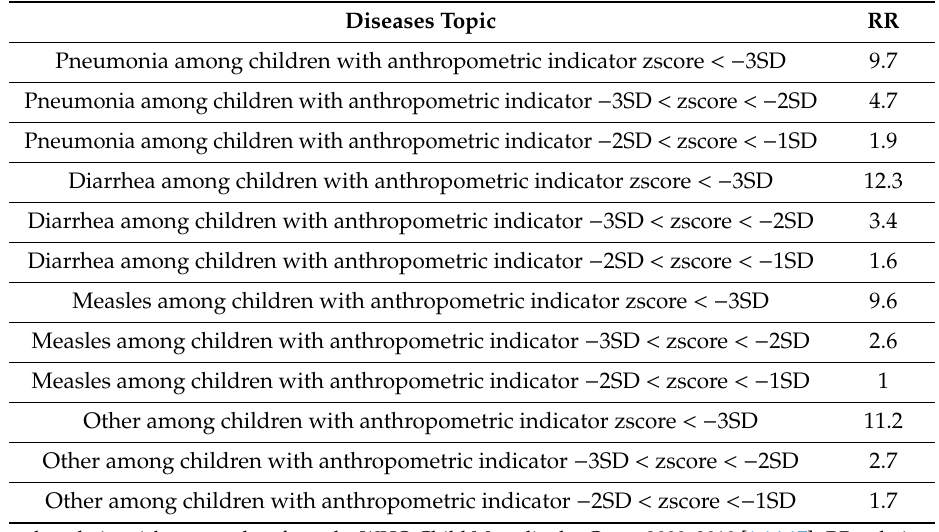
Table 1. Relative risk of mortality: mortality associated with severe, moderate, and mild wasting. Diseases